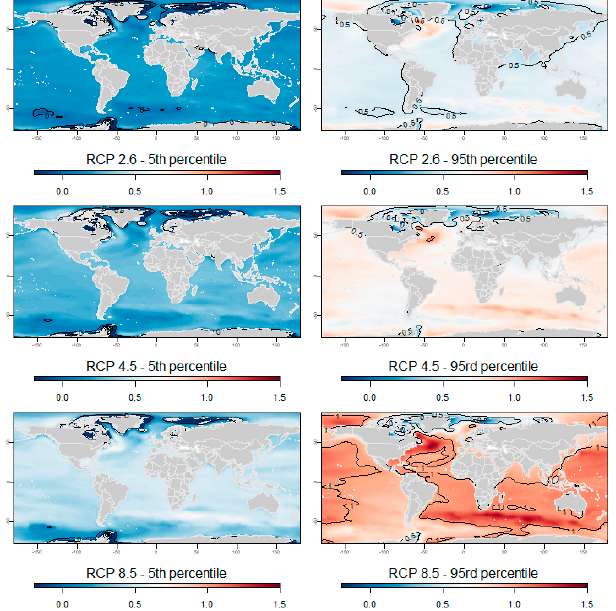
Figure A4. Low-end regional sea-level projections in 2100 for three RCP scenarios with respect to 1985–2006 (5th and 95th percentiles; unit: m).